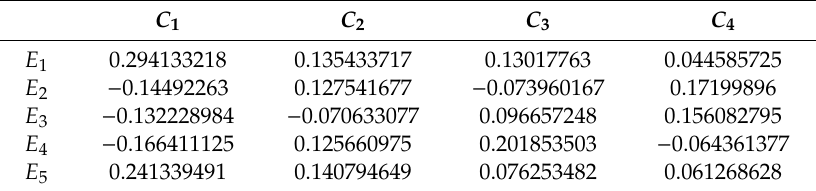
Table 8. The distance between the matrix N and the matrix Q .